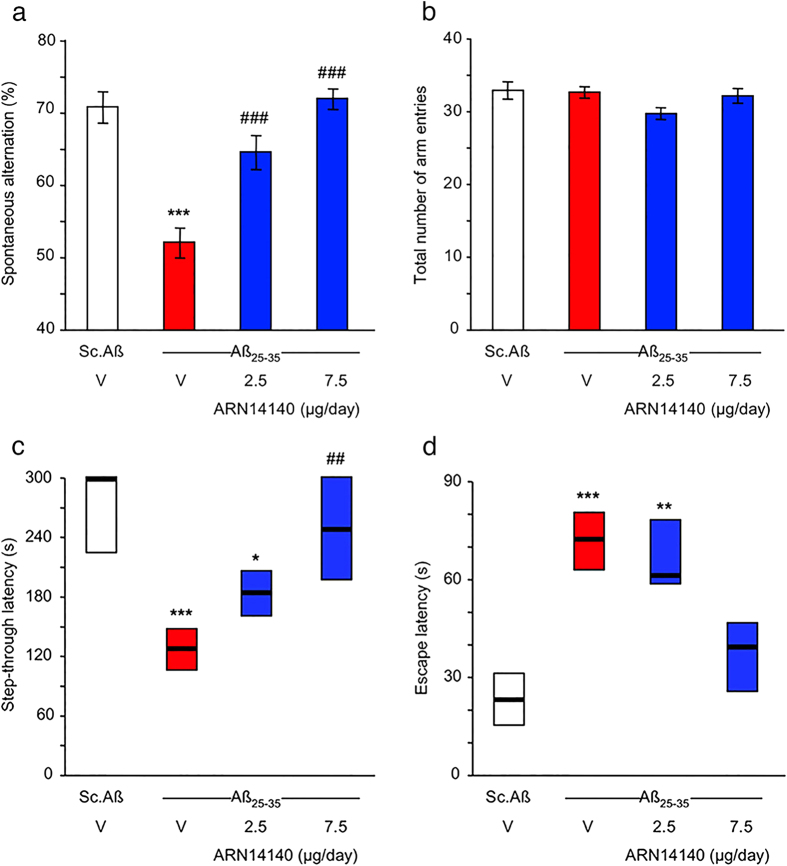
Effects of ARN14140 infusion for 7 days on Aβ25-35-induced spontaneous alternation deficits in mice.V, vehicle solution. N = 11–12 per group. ANOVA: F(3,45) = 20.1, p < 0.0001 in (a), F(3,45) = 1.22, p > 0.05 in (b). ***p < 0.001 vs. the Sc.Aβ/V-treated group; ###p < 0.001 vs. the Aβ25-35/V-treated group; Dunnett’s test in (a). Effects of ARN14140 infusion for 7 days on Aβ25-35-induced passive avoidance deficits in mice. (c) Step-through latency and (d) escape latency measured during the retention session. V, vehicle solution. Data show median and interquartile range (25–75%). N = 11–12 per group. Kruskal-Wallis ANOVA: H = 22.8, p < 0.001 in (c), H = 20.3, P < 0.001 in (d), *p < 0.05, **p < 0.01, ***p < 0.001 vs. the Sc.Aβ/V-treated group; ##p < 0.01 vs. the Aβ25-35/V-treated group; Dunn’s test in (c,d).